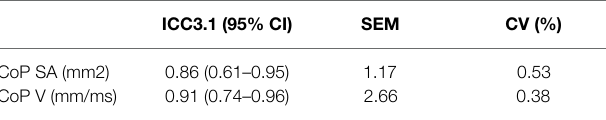
TABLE 2 | Test–retest reliability of variables.